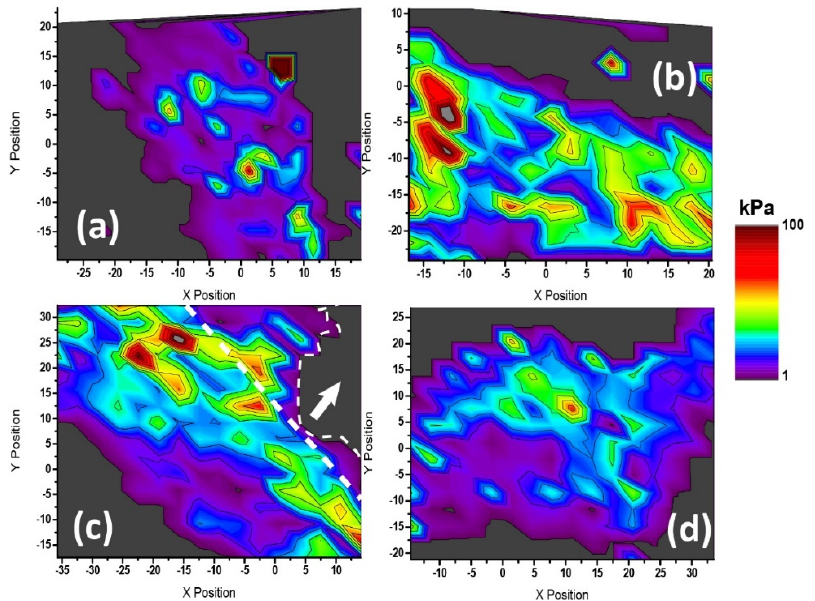
Figure 6. Cell mapping on elastic (Young’s) modulus variation resulting from P2X7R stimulation of rat cerebellar astrocytes. ( a ) Control (untreated), ( b ) BzATP, ( c ) A43, and ( d ) A43/BzATP. The thick dashed line in ( c ) delimits two neighboring astrocytes. The inner thin line and the arrow point at the area occupied by the body region of such an attached cell, from which values were removed to avoid a distorted interpretation. The color scale bar ranges in all cases between 1 and 100 kPa. Out-of-range values are shown in dark grey (i.e., glass